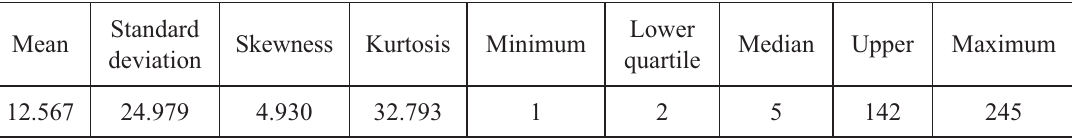
Fig. 2. Firm size Table 3. Firm size: Descriptive